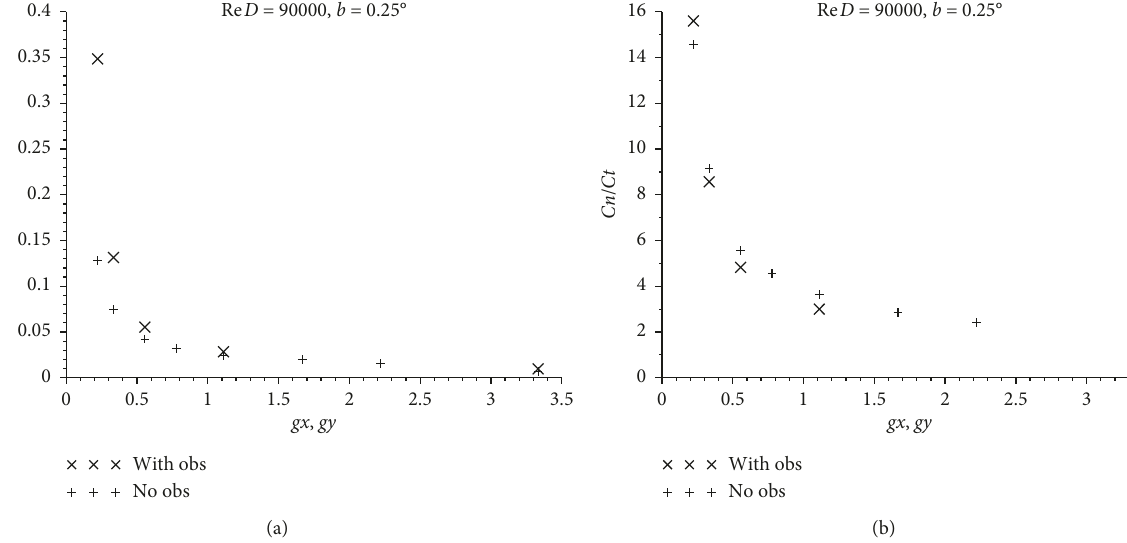
Figure 13: Evolution of Cn (a) and Cn / Ct (b) as a function of a square confinement gx � gy , comparison with and without small obstacle ( l � 1.1 and e � 0.033).